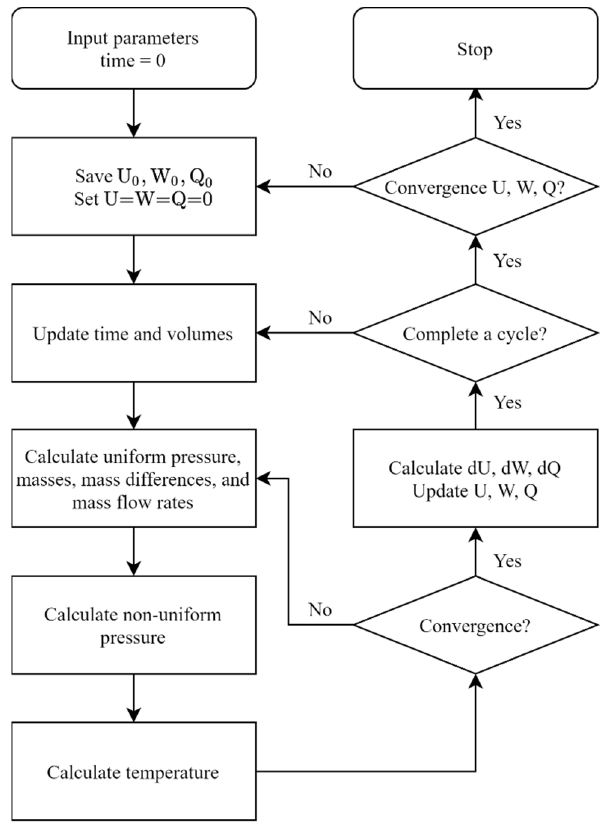
Figure 2. Flowchart of the modified thermodynamic model [17].